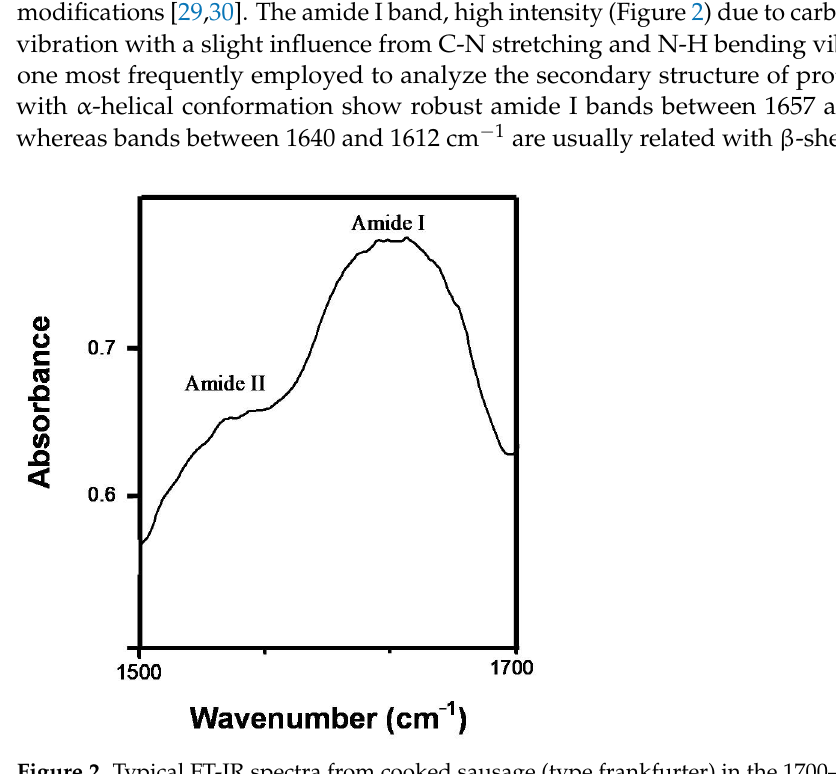
Figure 2. Typical FT-IR spectra from cooked sausage (type frankfurter) in the 1700–1500 cm − 1 . The mid-IR spectra of lipids encompass various bands in the 3000–1700 cm − 1 region and overlapping bands in the 1500–700 cm − 1 region. It is worth noting that in the elabora- tion of meat products with health-enhanced lipid content, infrared studies of the region between 3000–2800 cm − 1 are characterized by two strong bands at 2925 and 2854 cm − 1 (Figure 3) caused respectively from the asymmetric ( ν as CH 2 ) and symmetric ( ν s CH 2 ) stretching vibrations of the acyl CH 2 groups of lipids [31–33]. Modifications in lipid